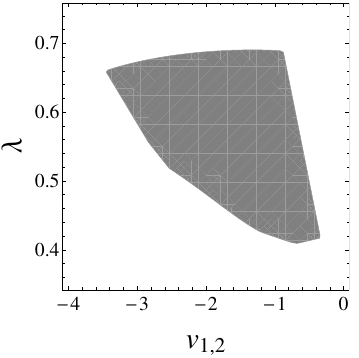
Figure 1. A - and L -stable methods of stage order q = 4 and order p = 5. The range of parameters λ and v 1 , 2 for which the methods are A - and L - stable is plotted in Figure 1. Again, this result was obtained by applying